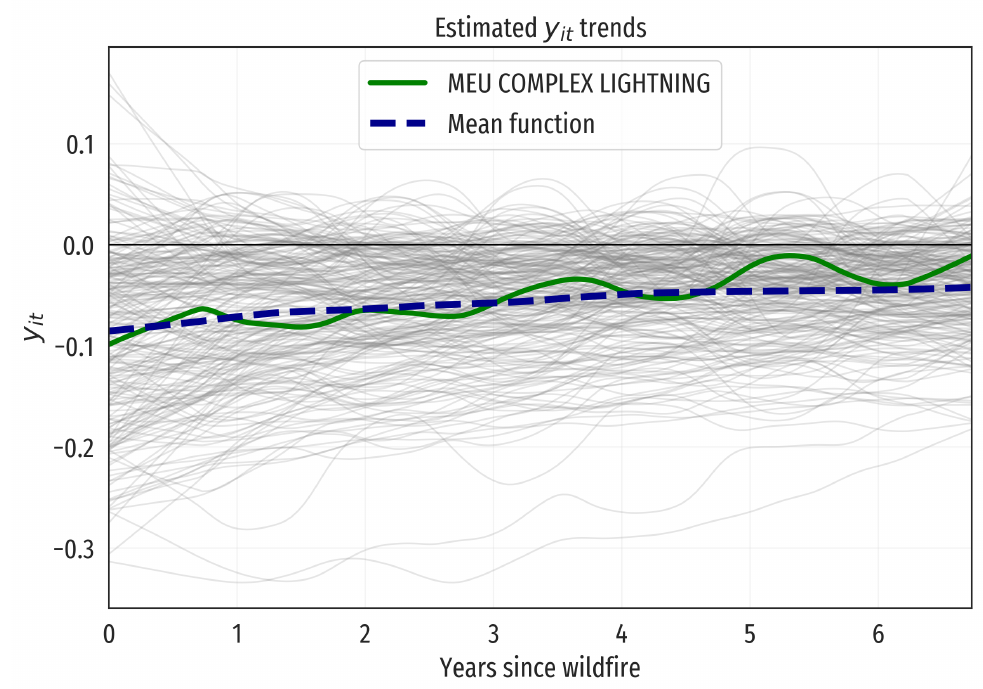
Figure 5. Plot of the functional dataset, composed by the extracted trends from the 243 estimated wildfire effects. The trend corresponding to the MEU LIGHTNING COMPLEX (MIDDLE) wildfire example has been marked in green. The functional mean is also represented (in dashed blue